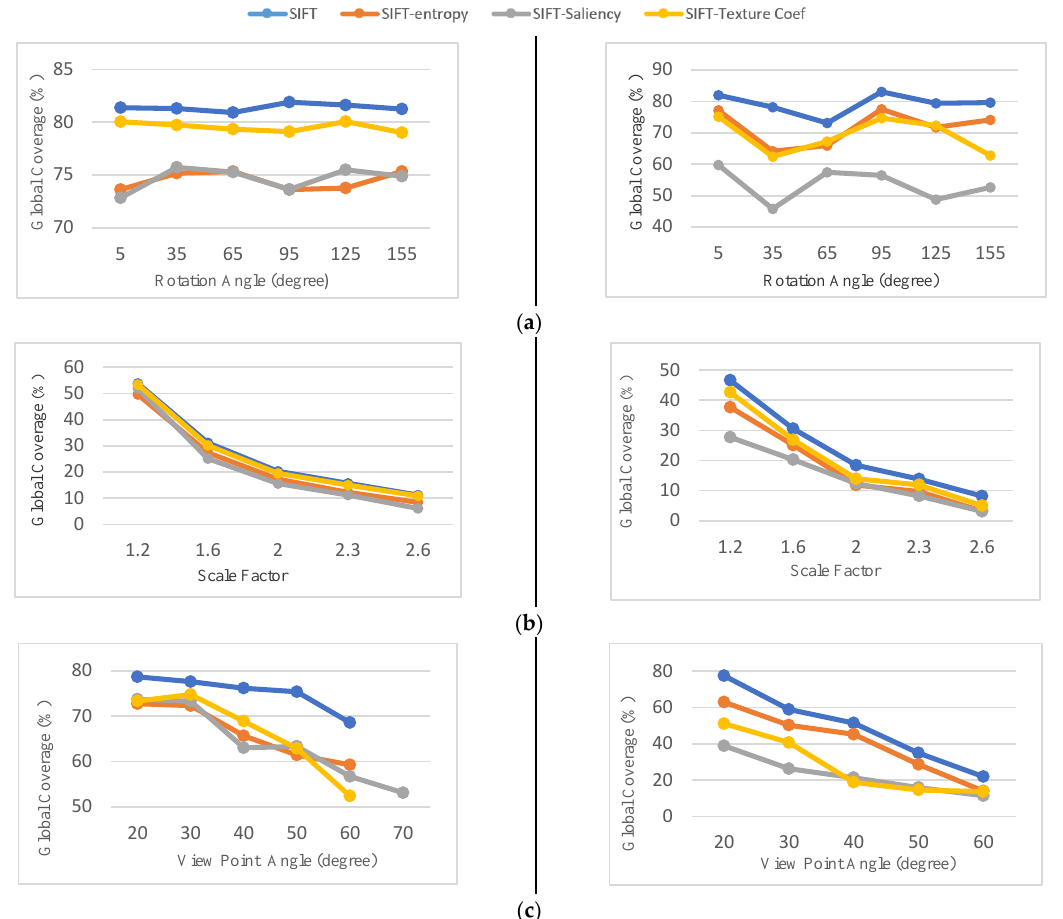
Figure 10. Recall results for the synthetic image pair of S1 (left column) and S2 (right column). ( a ) Rotation, ( b )scale, ( c ) viewpoint change.